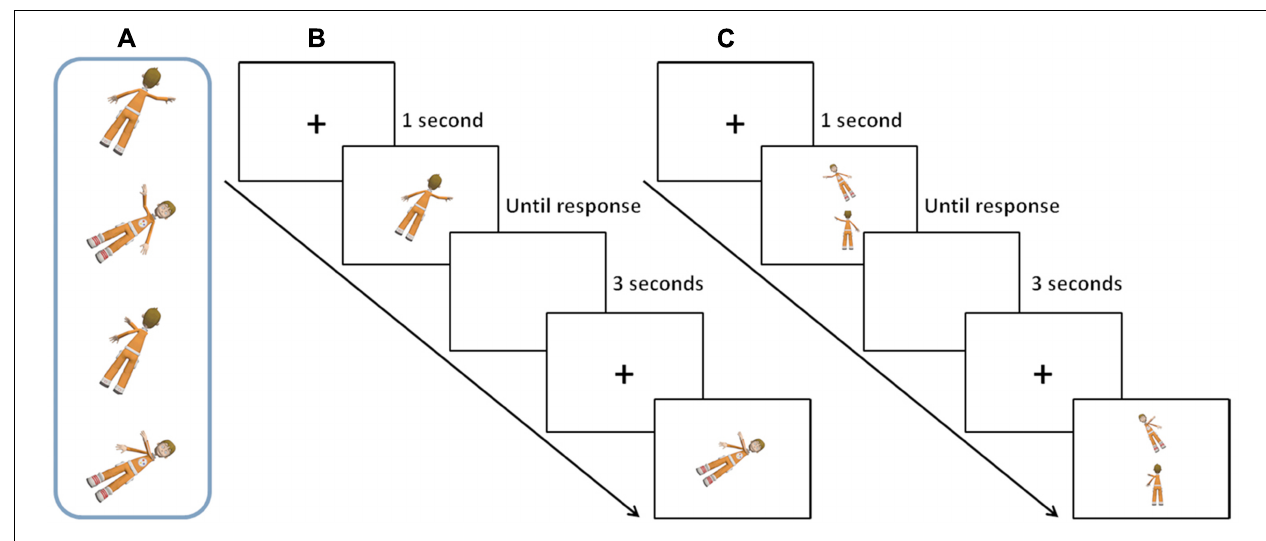
FIGURE 1 | Examples of stimuli and experimental trials from the twoTasks. Panel (A) shows examples of the images used in the twoTasks. Panel (B) shows example trials through the timeline of theTask 1 figure (own-body rotation). Panel (C) shows example trials through the timeline ofTask 2 figures (human-figure